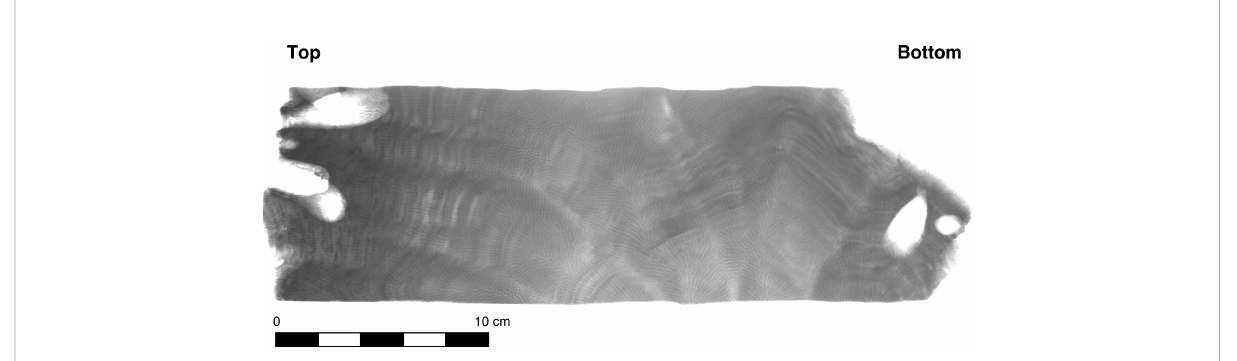
FIGURE 11 X-ray slice image of a core sample. Core sample was from the surface of the center of a fl at-top patch reef (F12-2). It was collected using a hydraulic drill with a diameter of 10 cm and a core length of 30 cm. The average age of the specimens collected from the sides of the core approximately 5 cm from the surface was 3489.2 ± 16.6 years.